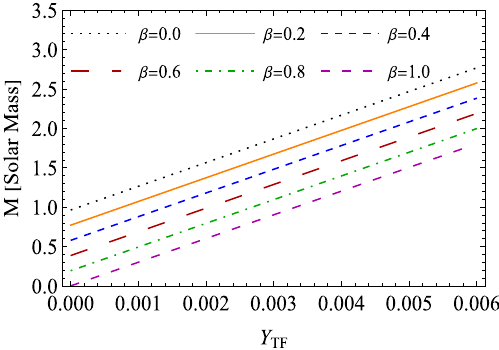
Fig. 8 The variation of Mass ( M / M (cid:8) ) versus complexity factor Y TF for solution